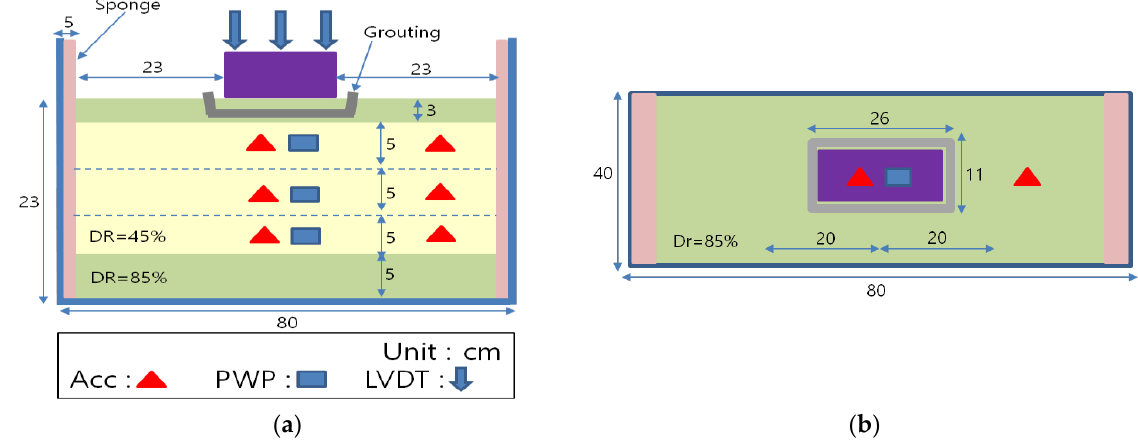
Figure 3. Schematic diagram of model: ( a ) Plan view; ( b ) Front view. Table 1. Properties of Jumunjin standard sand.